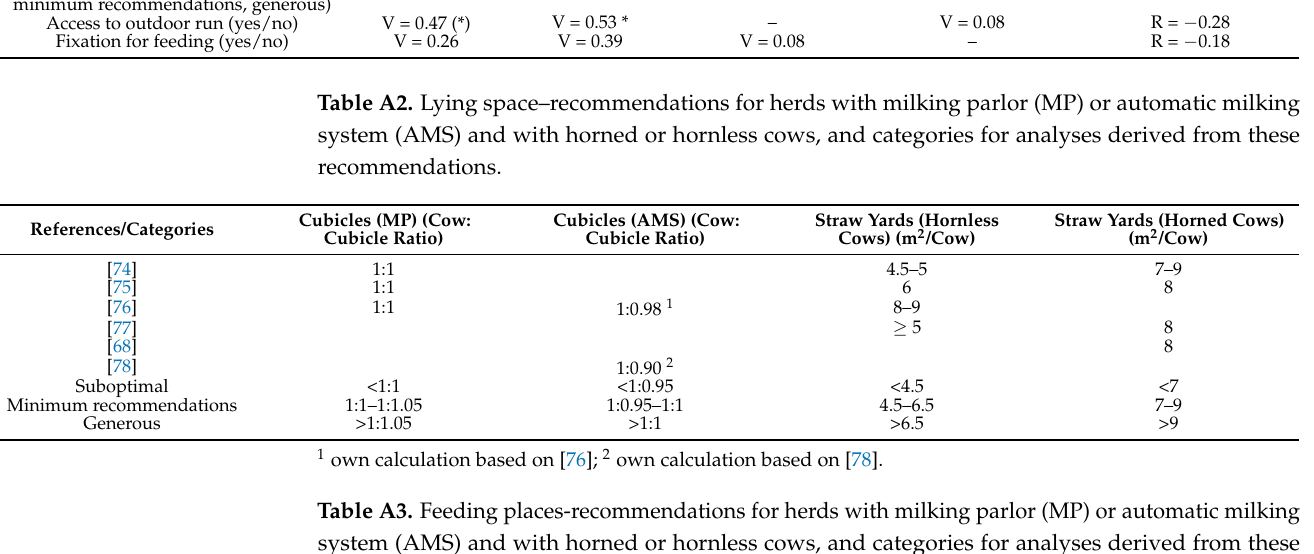
Voluntary Contact to Cows